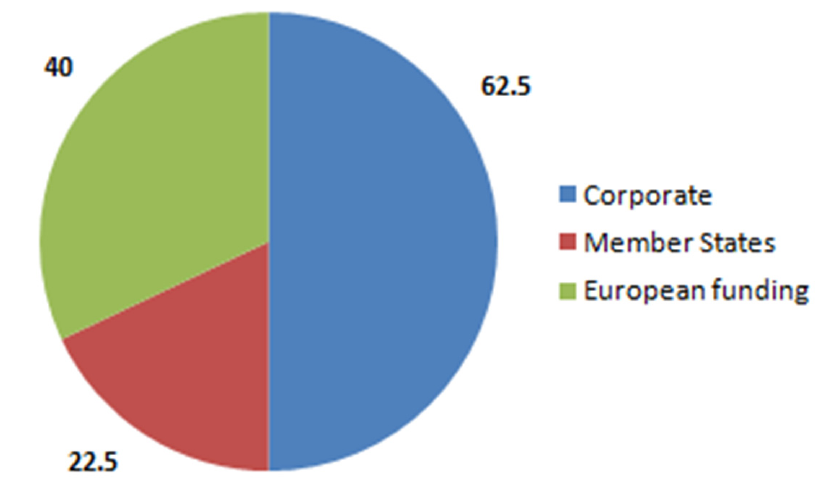
Figure 23. Total research and development investment in wave and tidal energy projects in 2011 (in M EUR).